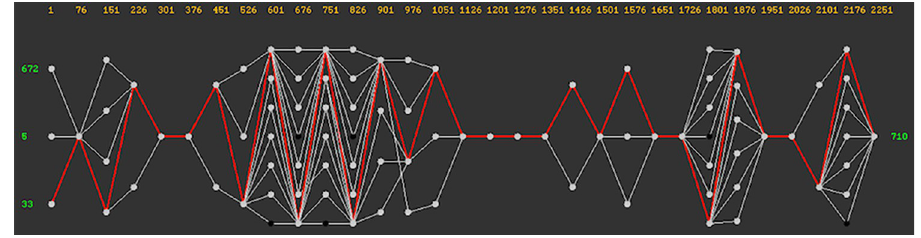
Fig 5. Network based diversity across the full gp120 case-study alignment: Thirty non-overlapping windows of length 75 nt fitted along the length of the alignment. The clustering threshold within each was 0.2. The orange numbers along the top indicate window locations, whilst the green numbers on each side indicate the number of sequences observed within nodes (clusters) at the ends of the network. Grey dots are clickable nodes, that when clicked will highlight the paths (in red) of the sequences passing through across the remainder of the network. Here the highlighted paths are a result of clicking the bottom left most node (containing 33 sequences). Information from sequences highlighted in this manner can be extracted using the sub-options of the “Node Path” top-level menu within the software as indicated within the demonstration video [35], and under the software help menus. This network was printed using the “Print PNG” button located within the control panel of the